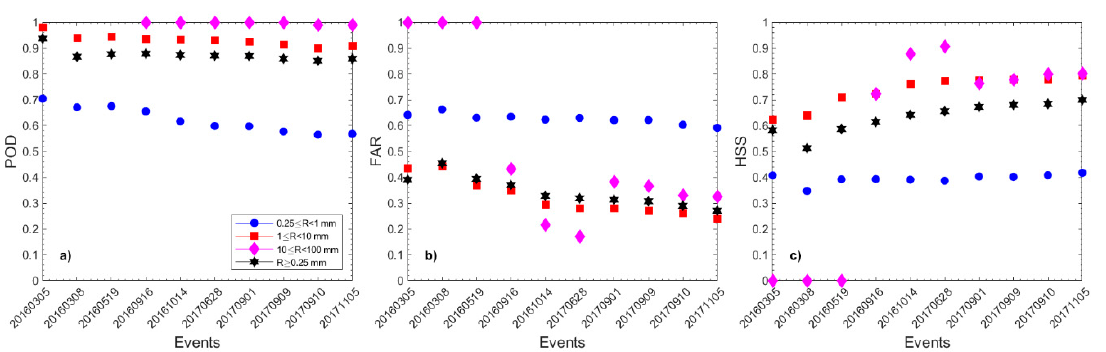
Figure 8. ( a ) Probability of Detection (POD), ( b ) False Alarm Ratio (FAR), and ( c ) Heidke Skill Score (HSS) scores calculated by comparing the RAINBOW outputs with the Random Generator of Spatial Interpolation from uncertain Observations (GRISO) data (taken as reference) on a regular 0.25° × 0.25° grid for 10 case studies. A minimum cumulated rain threshold is set at 0.25 mm and three different intervals of cumulated rain are considered: light 0.25–1 mm, moderate 1–10 mm, and heavy 10–100 mm.